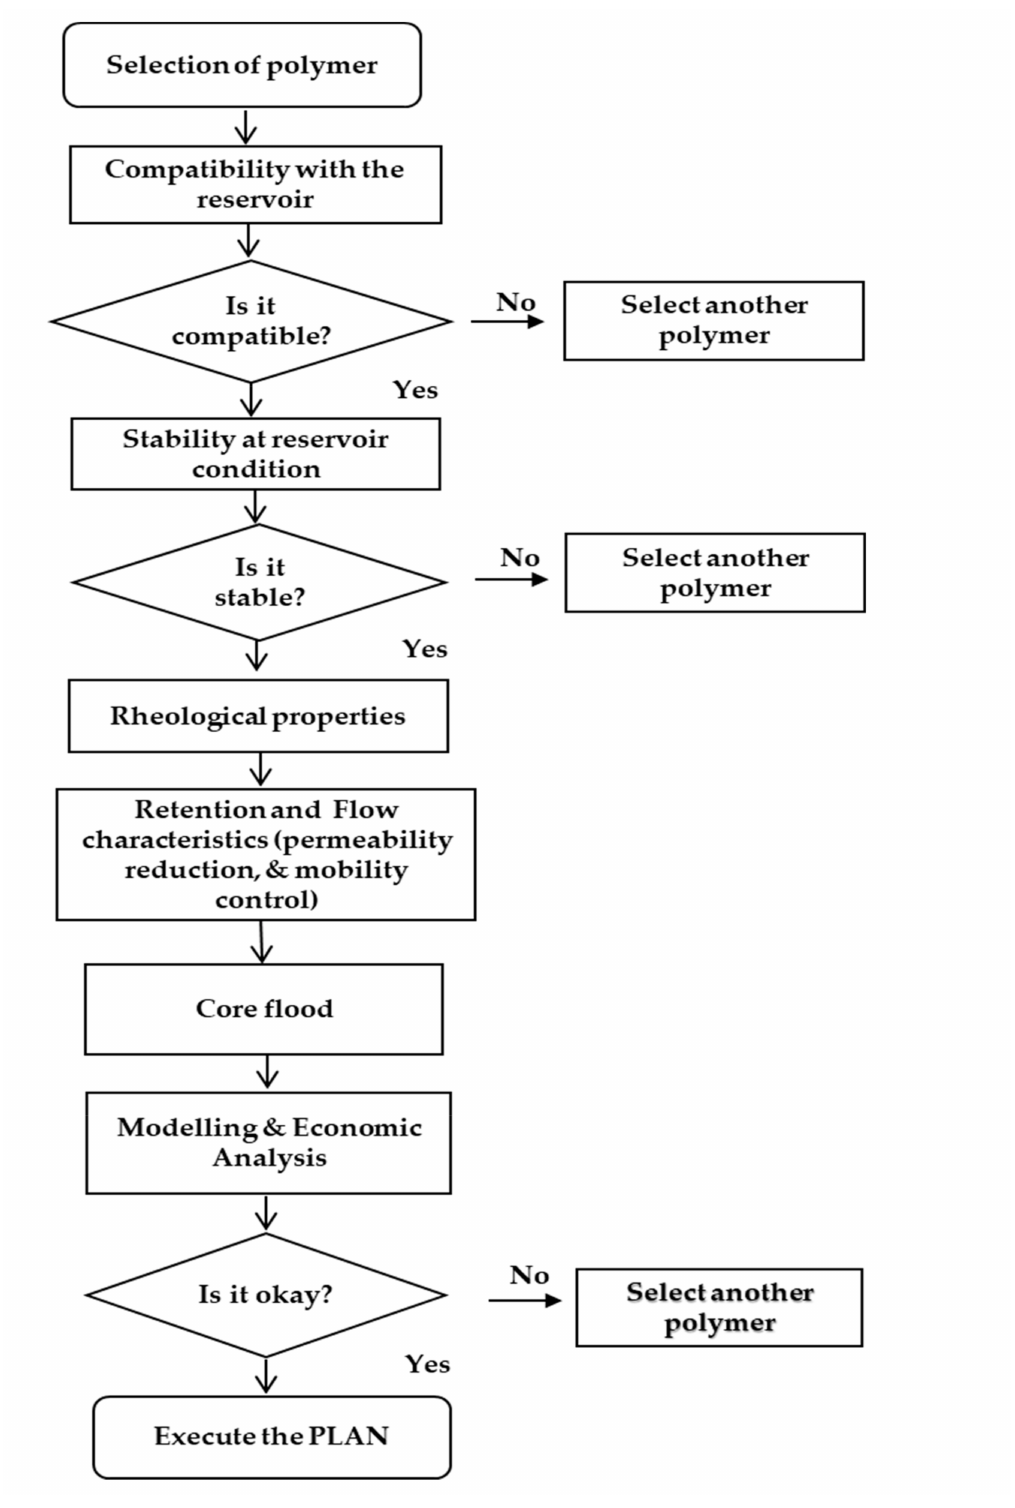
Figure 20. Schematic for polymer design